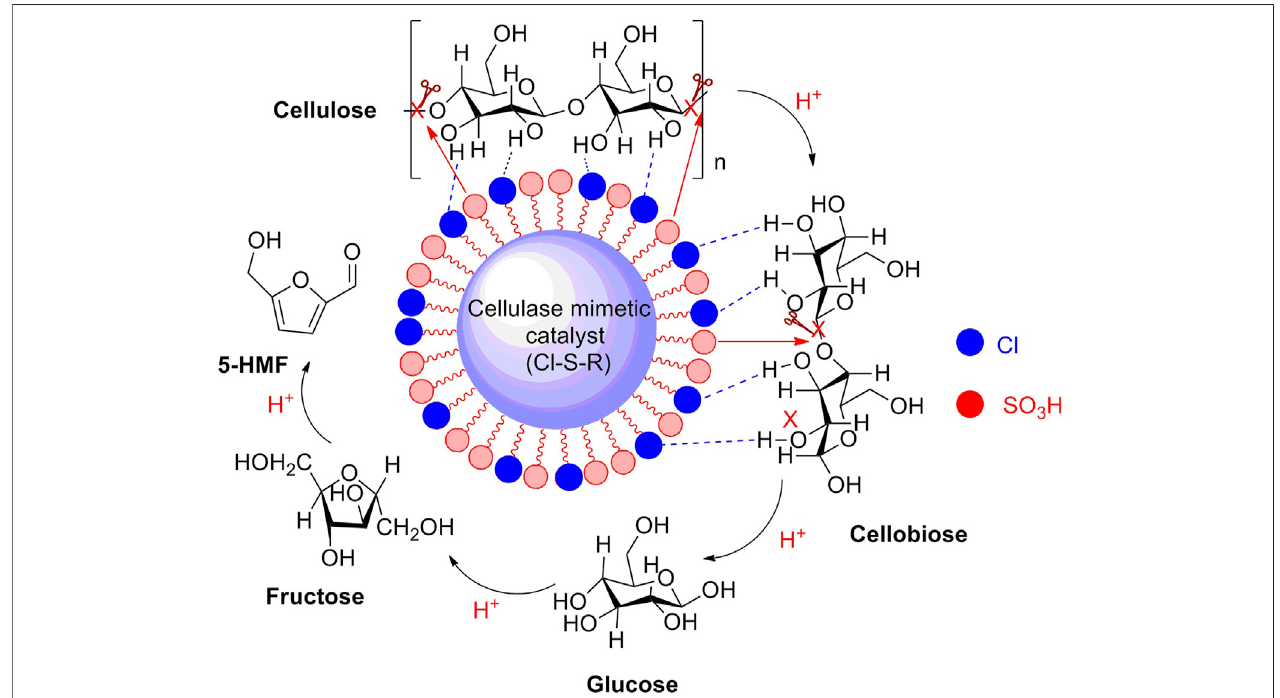
FIGURE 5 | Catalyst SC-FAR-800 employed for biomass conversions into 5-HMF, with the assistance of microwave irradiation.